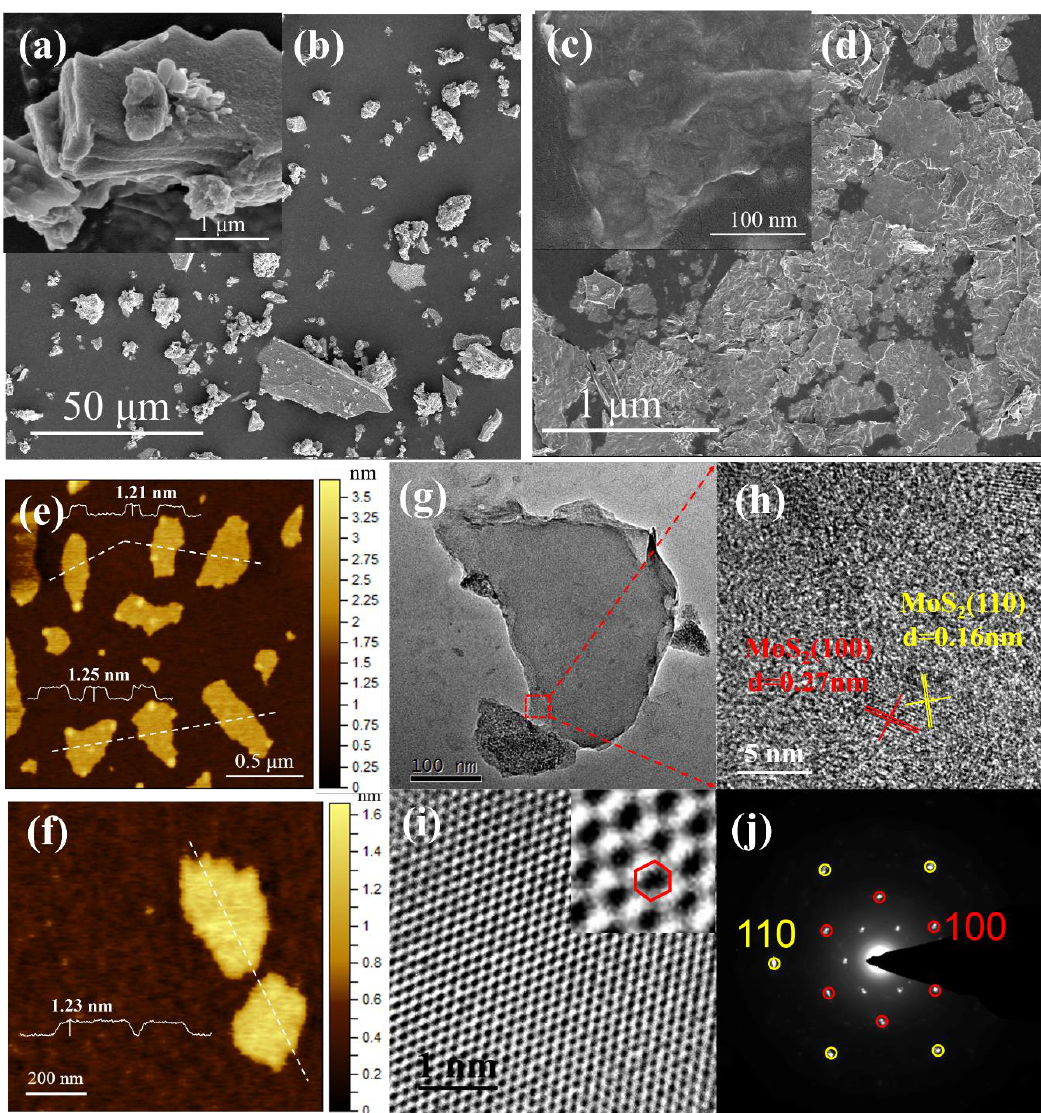
Figure 2. Field emission scanning electron microscope (FESEM) images ( a – d ) of the bulk MoS 2 and MoS 2 -NS, atomic force microscope (AFM) images (b, f ), height profiles (inset), (transmission electron microscope) TEM and high-resolution transmission electron microscope (HRTEM) images of MoS 2 nanosheets ( g – i ), and the fast Fourier transforms (FFT) pattern of MoS 2 NS ( j ).